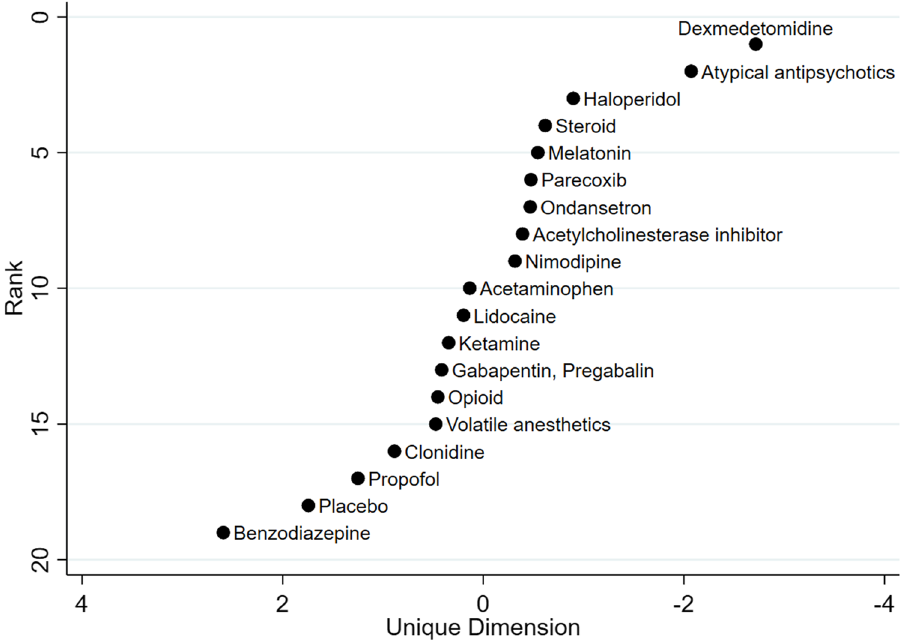
Figure 4. Relative ranking plots of drugs based on multidimensional scaling approach. The upper located interventions are ranked higher than the intervention located